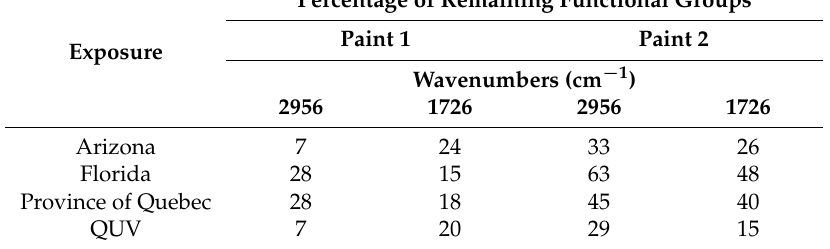
Table 4. Results from quantitative analyses made from ratios between most exposed samples and unexposed samples. Percentage of Remaining Functional Groups Paint 1 Paint 2 Exposure Wavenumbers (cm − 1 ) 2956